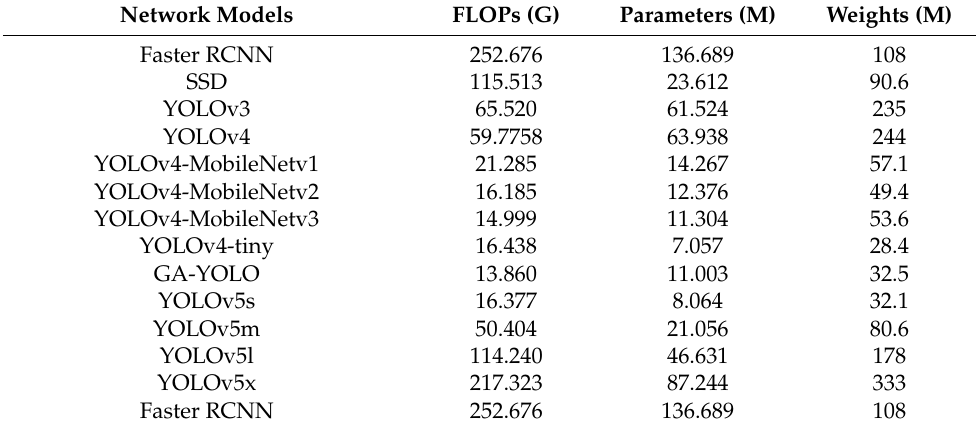
Table 6. Comparison of calculation volume, parameter volume, and weight file of different network